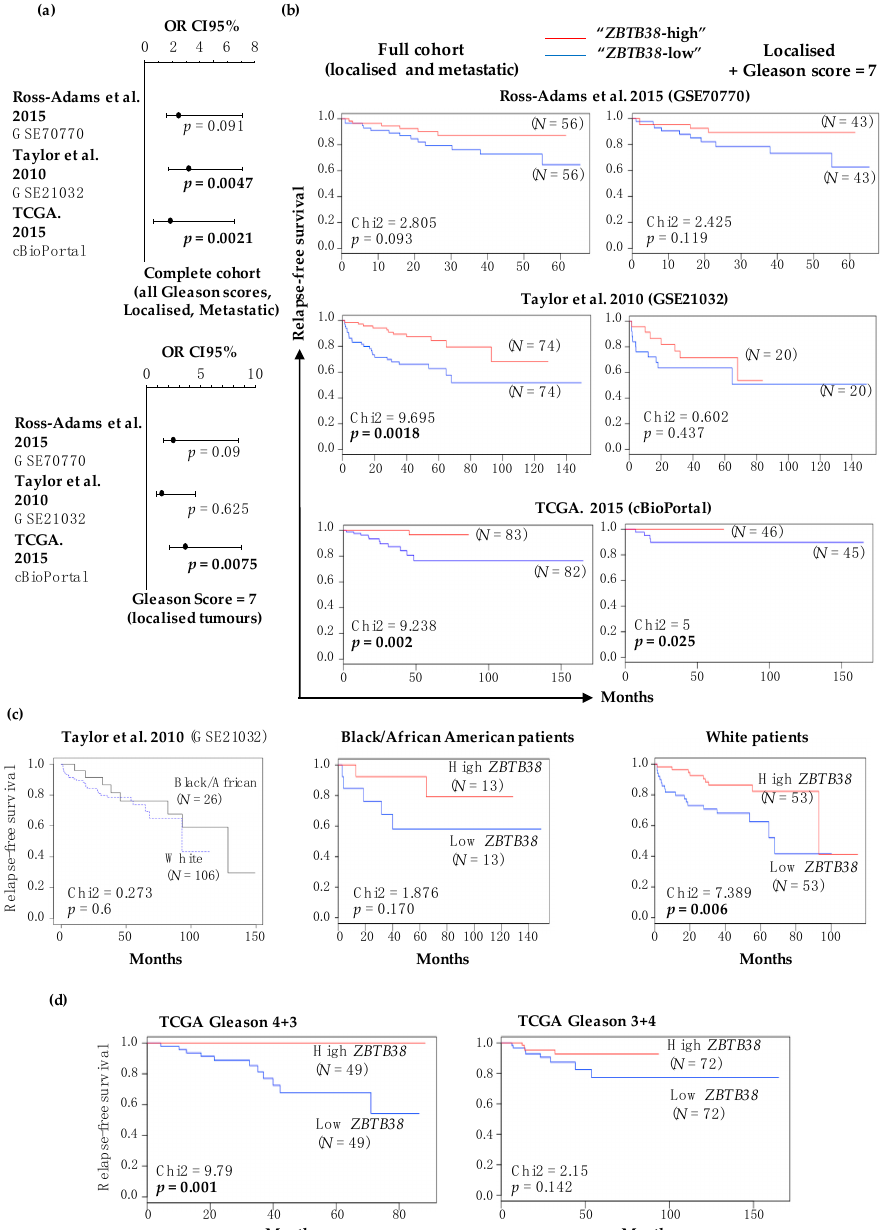
Figure 3. Prognostic significance of ZBTB38 expression in patients with prostate cancer. ( a ) Association between low levels of ZBTB38 expression and the relapse. Top panel: study including all patients. Bottom panel: study including patients with intermediate risk cancer (i.e., Gleason score = 7). ( b ) Association between ZBTB38 expression and disease-free survival in three independent cohorts of patients. Left panel: disease-free survival of all patients according to ZBTB38 expression levels. Right panel: disease-free survival of intermediate risk (Gleason score = 7) patients according to ZBTB38 expression levels. ( c ) Association between ZBTB38 expression and disease-free survival in white and black/African American patients from the Taylor’s cohort. Left panel: disease-free survival of white and black/African American patients. Centre panel: disease-free survival of black/African American patients according to ZBTB38 expression levels. Right panel: disease-free survival of white patients according to ZBTB38 expression levels. ( d ) Association between ZBTB38 expression and disease-free survival of patients with Gleason score 3 + 4 and 4 + 3 from the TCGA cohort. N : number of patients per class. Significant p -value ( p < 0.05) are highlighted in